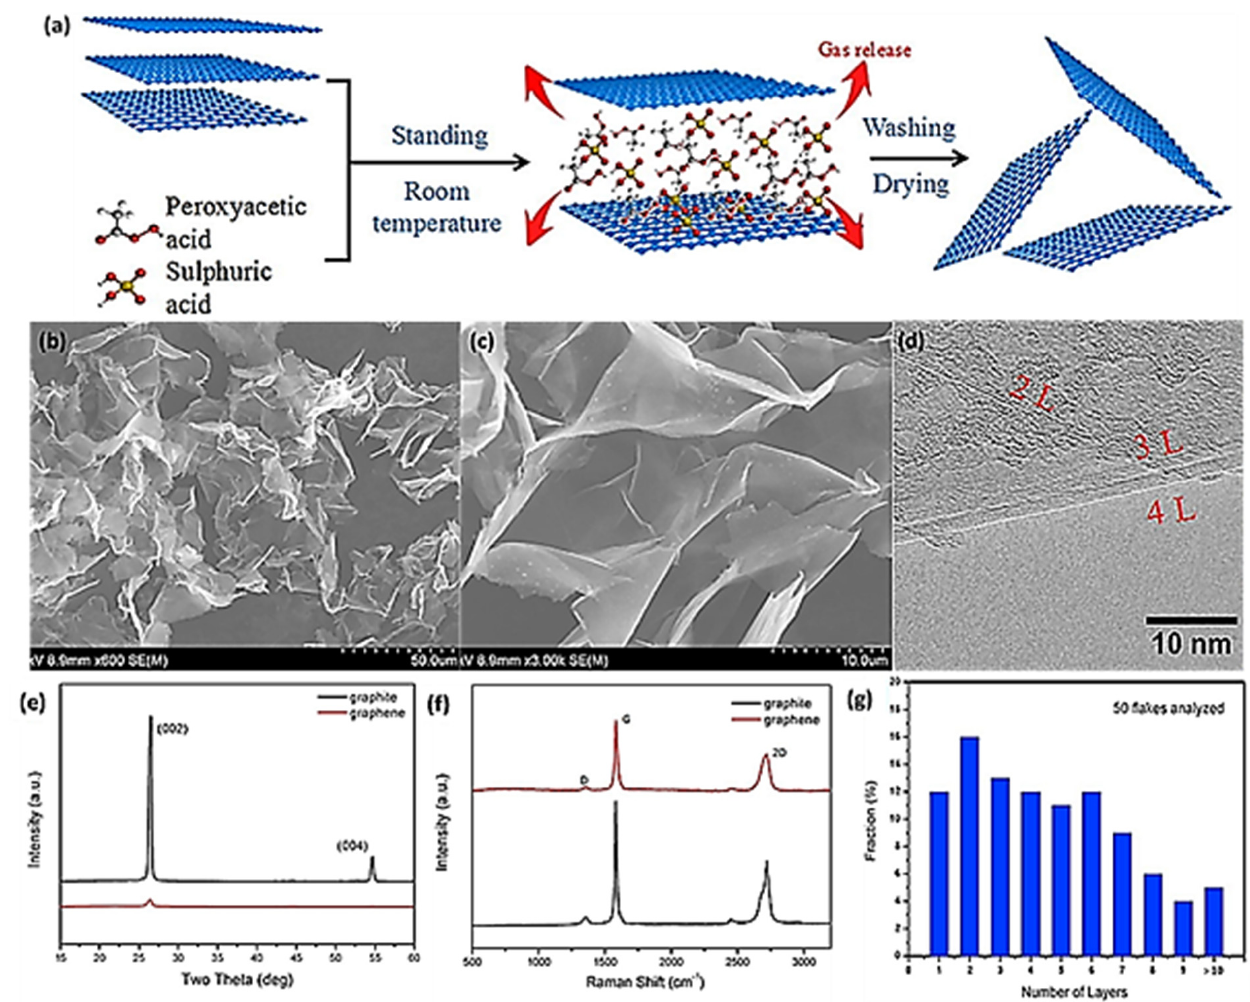
Figure 5 . ( a ) Graphical representation of graphene production via chemical exfoliation; ( b , c ) SEM micrographs of as-obtained graphene; ( d ) HR-TEM image; ( e ) XRD spectra of graphite and pristine graphene; ( f ) Raman spectra of graphite and pristine graphene; and ( g ) thickness of graphene with diverse number of layers represented statistically. Adopted with permission from [65].